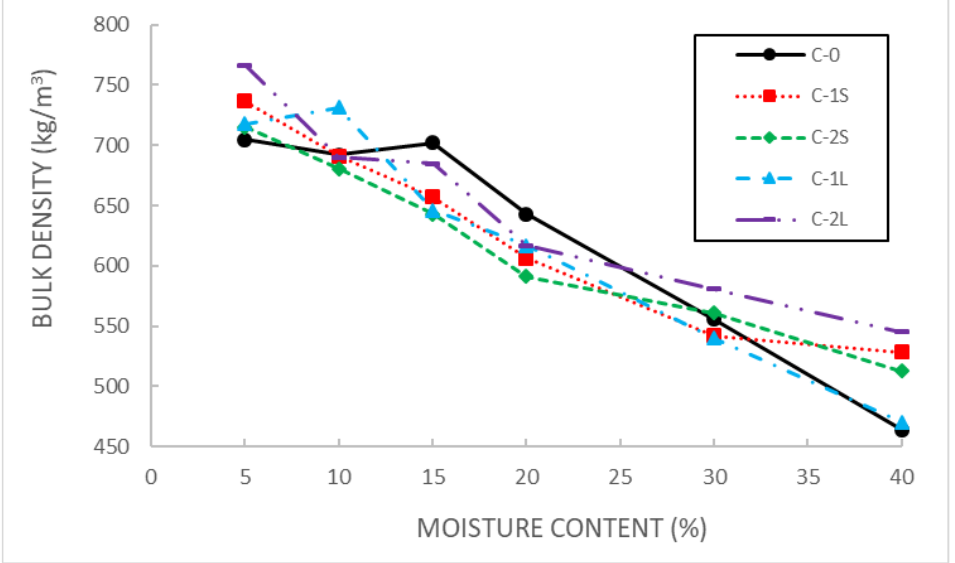
Figure 3. Bulk dry densities.